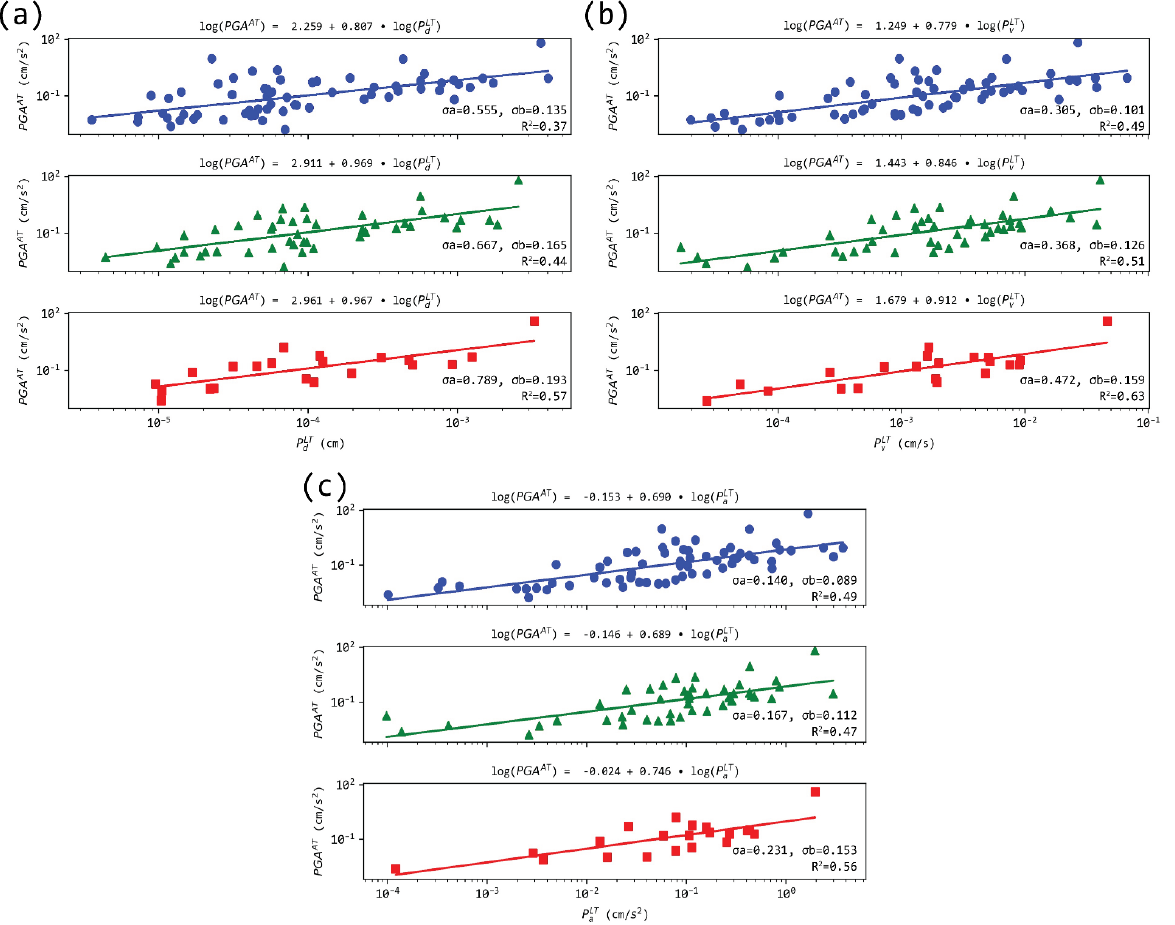
Figure 10. Regression models between PGA measured in Athens (AT) and peak displacement P d ( a ), velocity P v ( b ), and acceleration P a ( c ) measured in Loutraki (LT), for the three t w . Notable scatter is observed, compared to the individual station analysis. The rest of the notation as in Figure 3.